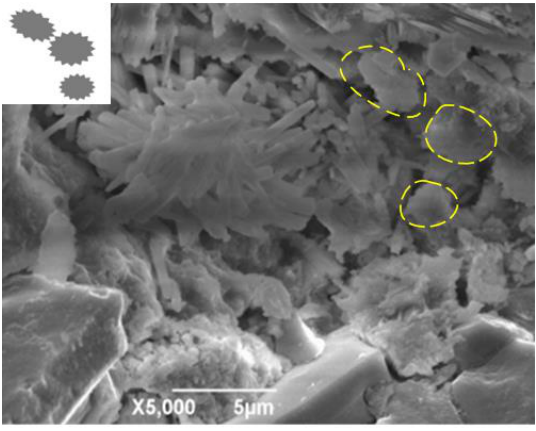
Figure 10. Bubbles and voids in RAC.